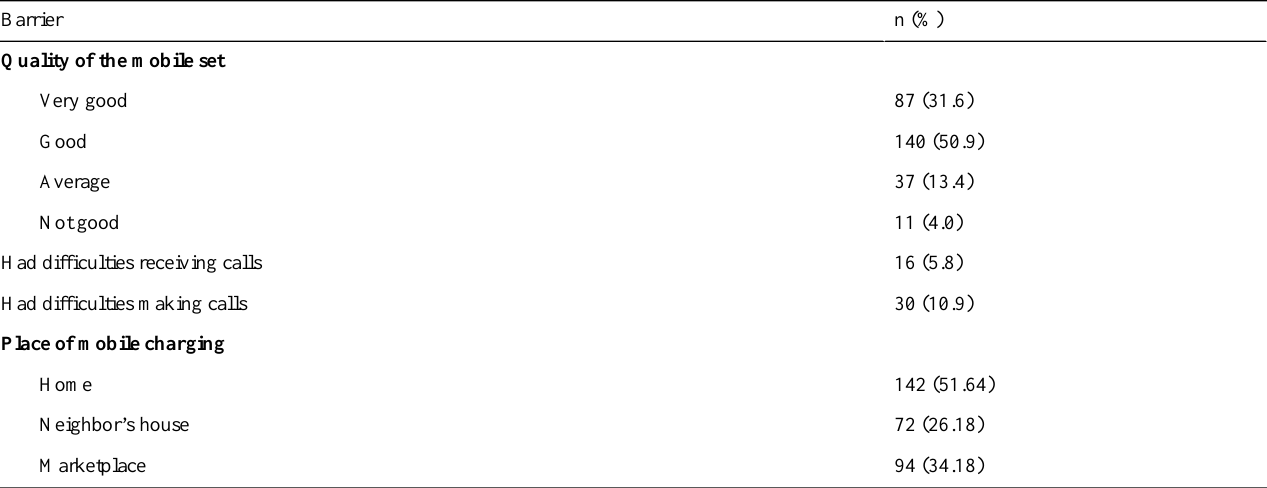
Table 3. Barriers in using mobile platform for nutrition counseling and cash transfer (n=275).